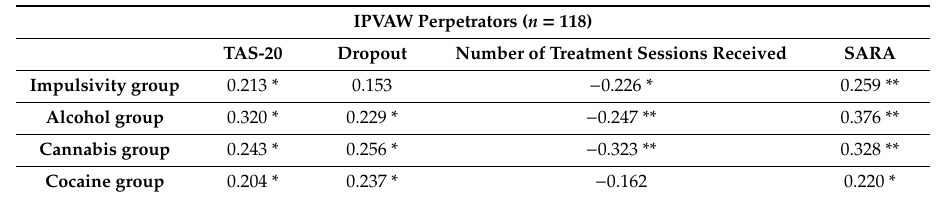
Table 2. Correlation coe ffi cients for self-reported impulsivity (dummy coded) and drug misuse classification with dropout and risk of reo ff ending. * p < 0.05, ** p <